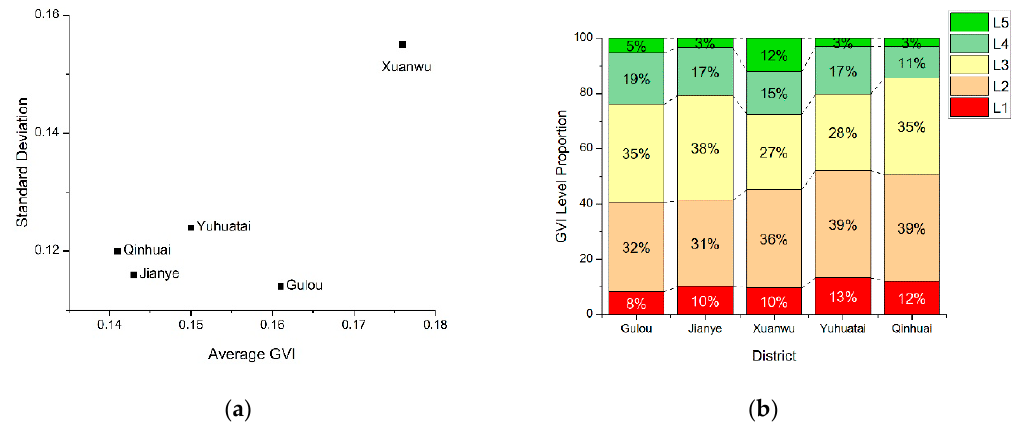
Figure 6. District distribution of street greenery. ( a ) Average and standard deviation of the GVI in each district. ( b ) Proportions of the 5 GVI levels in the 5 districts. The levels include L1 (0–0.05), L2 (0.05–0.15), L3 (0.15–0.25), L4 (0.25–0.35) and L5 (0.35–1).